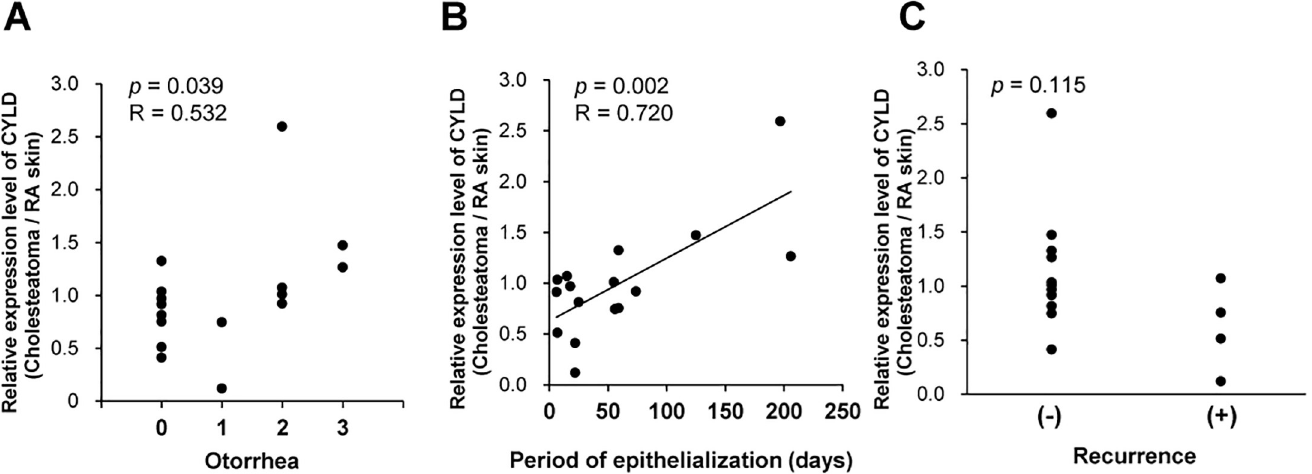
Fig 3. Correlations between the relative expression level of CYLD and the clinicopathological characteristic in cholesteatoma. (A-C) Correlations between the relative expression level of CYLD in cholesteatoma with the grade of otorrhea (A), the period of epithelialization (B), and the recurrence (C).